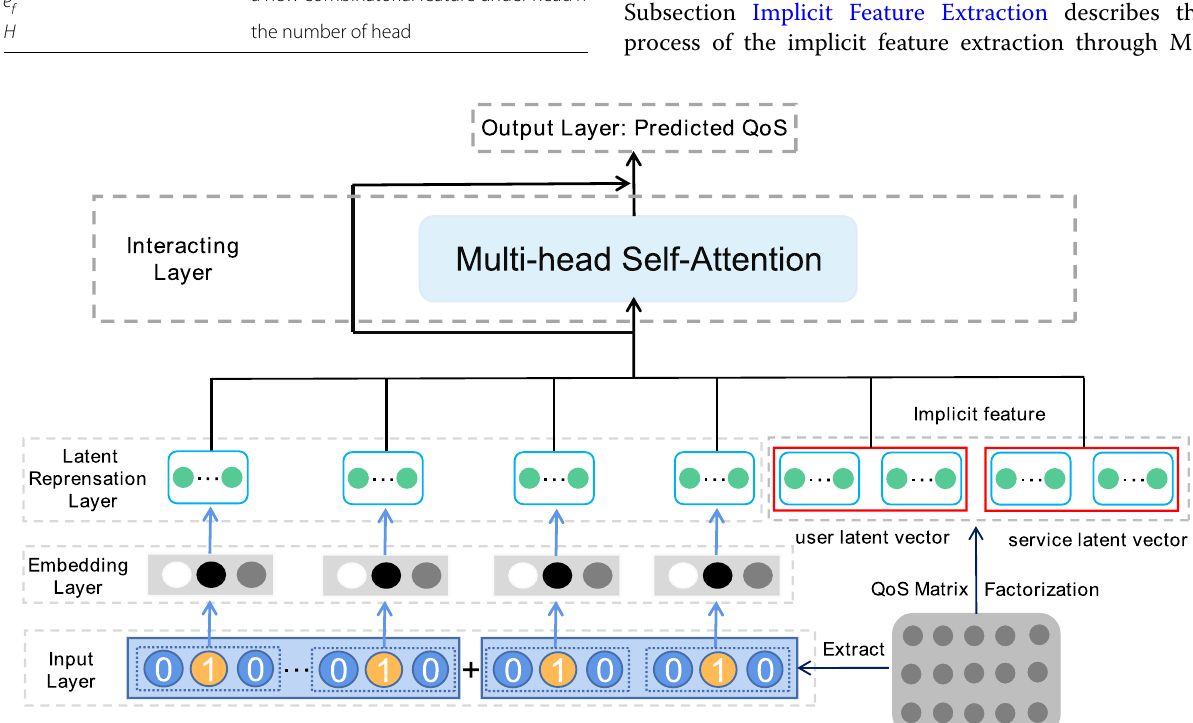
Fig. 2 The architecture of Matrix Factorization Automatic Interaction Network